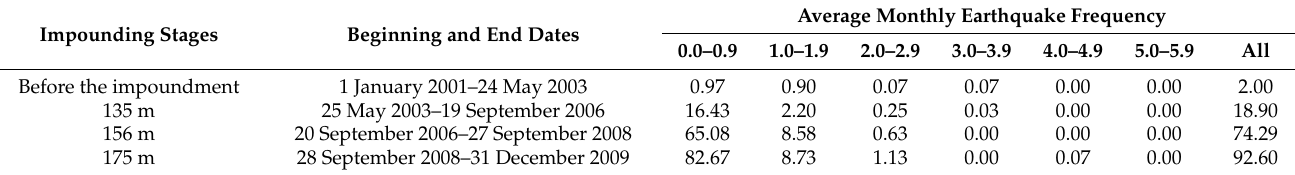
Table 2. Average monthly earthquake frequency in different magnitude grades of the study area and in different impoundment stages of